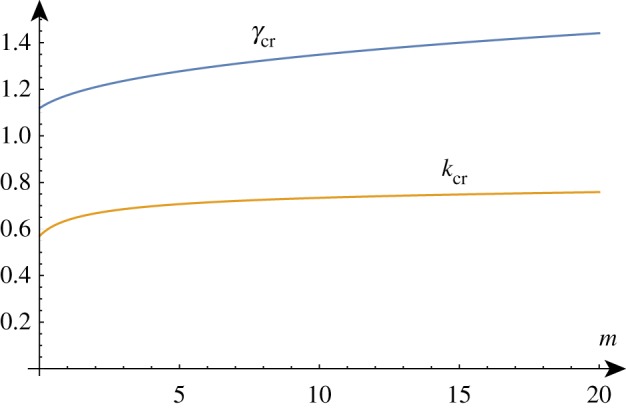
kcr and γcr as functions of m for β = 10. (Online version in colour.)